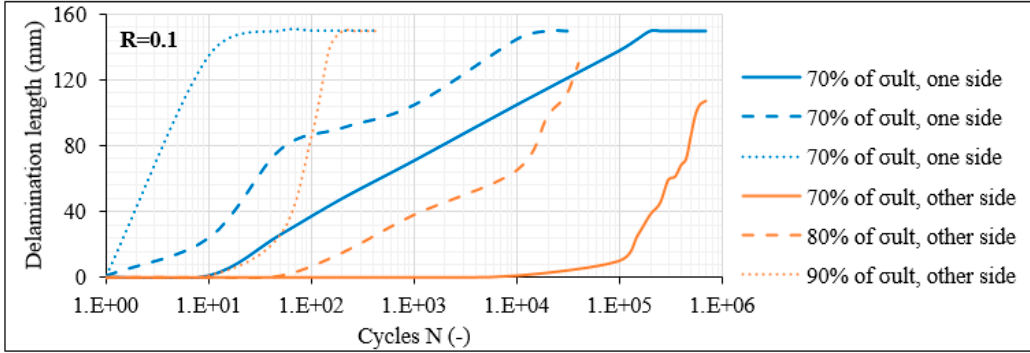
Figure 14. Delamination crack growth versus N in [0°/60°/ − 60°] 2s laminates for R = 0.1.